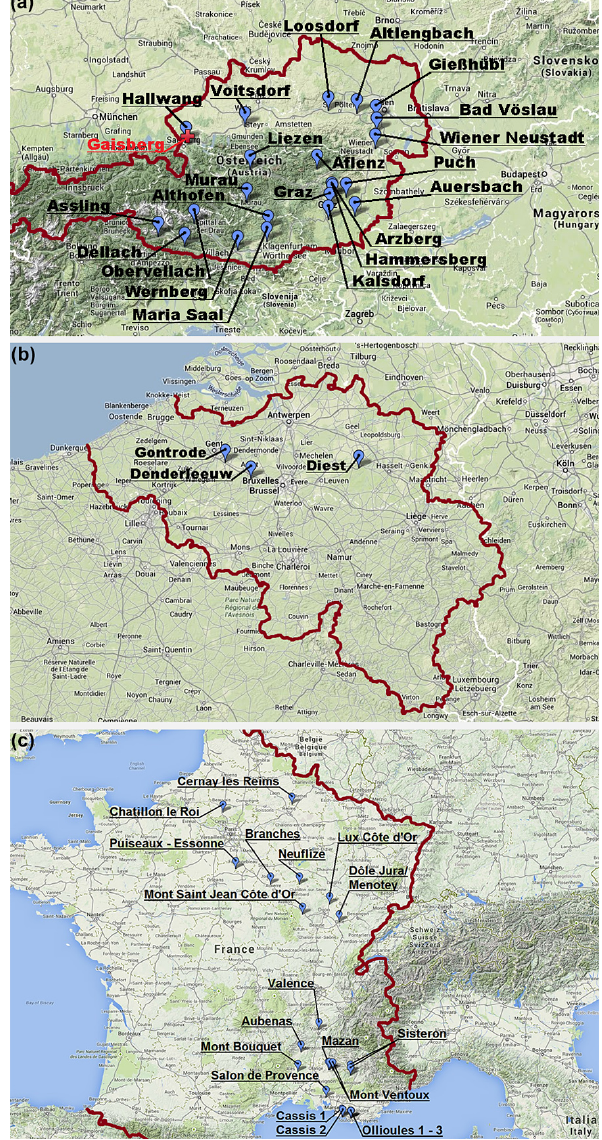
Figure 3. Measurement locations for (a) Austria, (b) Belgium and (c)